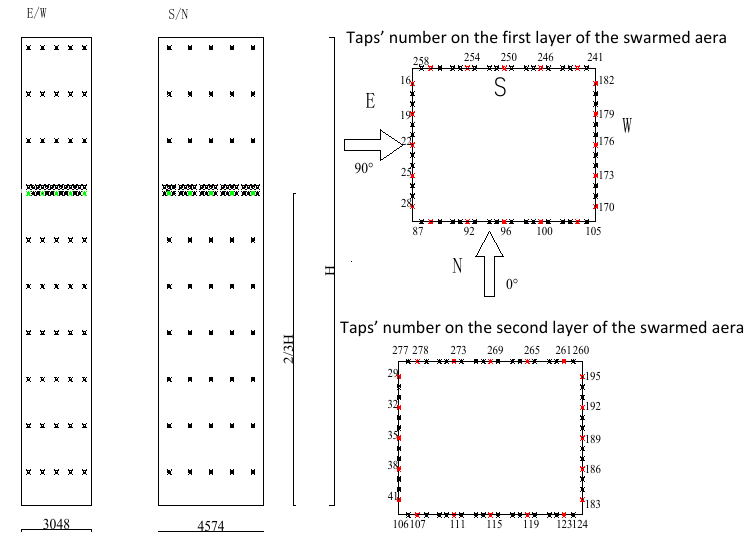
Figure 3. Measuring tap location for scale model (unit: cm).